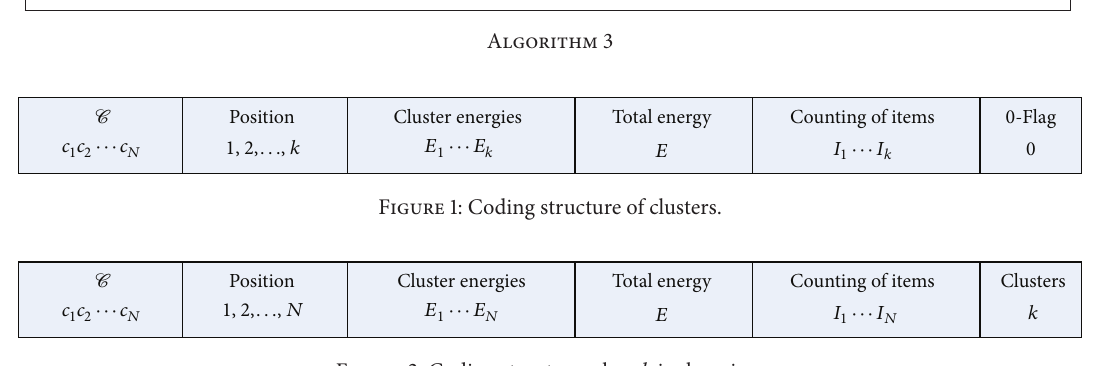
Figure 2: Coding structure when 𝑘 is